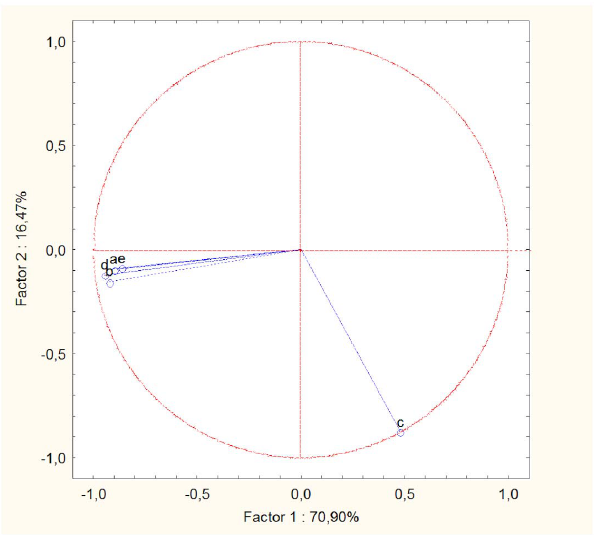
Figure 1. Results of the principal components analysis (PCA) for resident males. The circle shows the correlation between the original variables and the two new components. a = male standardized dominance rank, b = male leadership score, c = rate of aggression displayed by males towards females, d = rate of the net number of approaches within 1 metre that males received by females, e = rate of affiliative behaviour displayed by males towards females. Pearson correlations between factor 1 of the PCA and the original variables were: 2 0.90 (a), 2 0.92 (b), 0.48 (c), 2 0.95 (d), 2 0.87 (e); Pearson correlations between factor 2 and the original variables were: 2 0.09